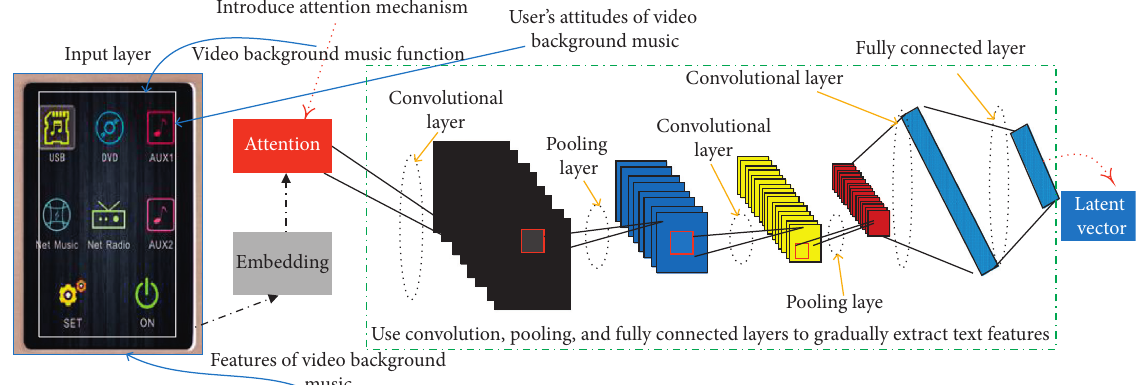
Figure 3: Structure diagram of video background music feature mining based on